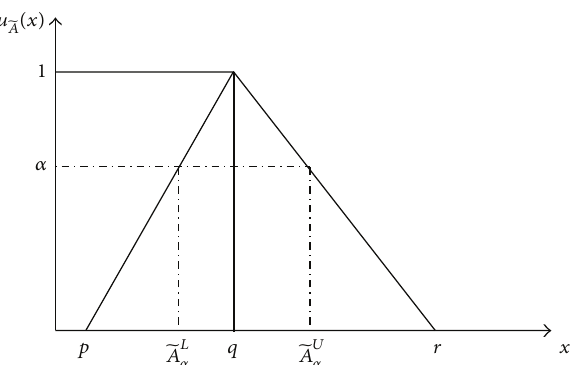
Figure 1: Triangular fuzzy number with an 𝛼 -cut.